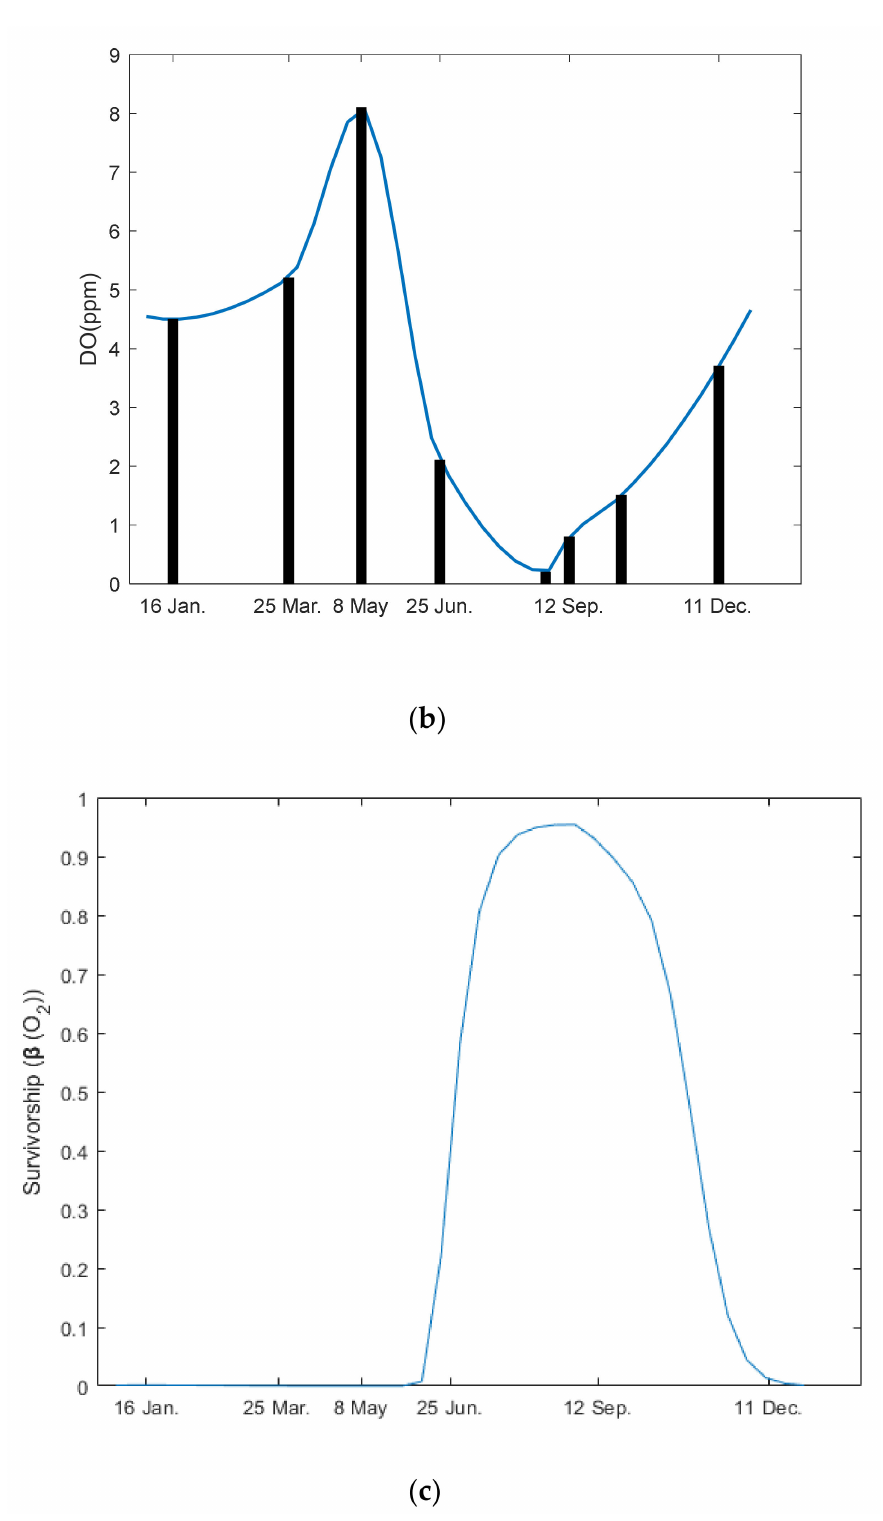
Figure 1. ( a ) Survivorship generating function, β ( O 2 ) , of Aurelia coerulea polyps; ( b ) dissolved oxygen concentrations observed at Tokyo Inner Bay in 2001 at 4 m depth [bar] [13] and the interpolated curve; ( c ) the annual survivorship curve, β ( t ) , constructed by inserting the DO data into the survivorship generating